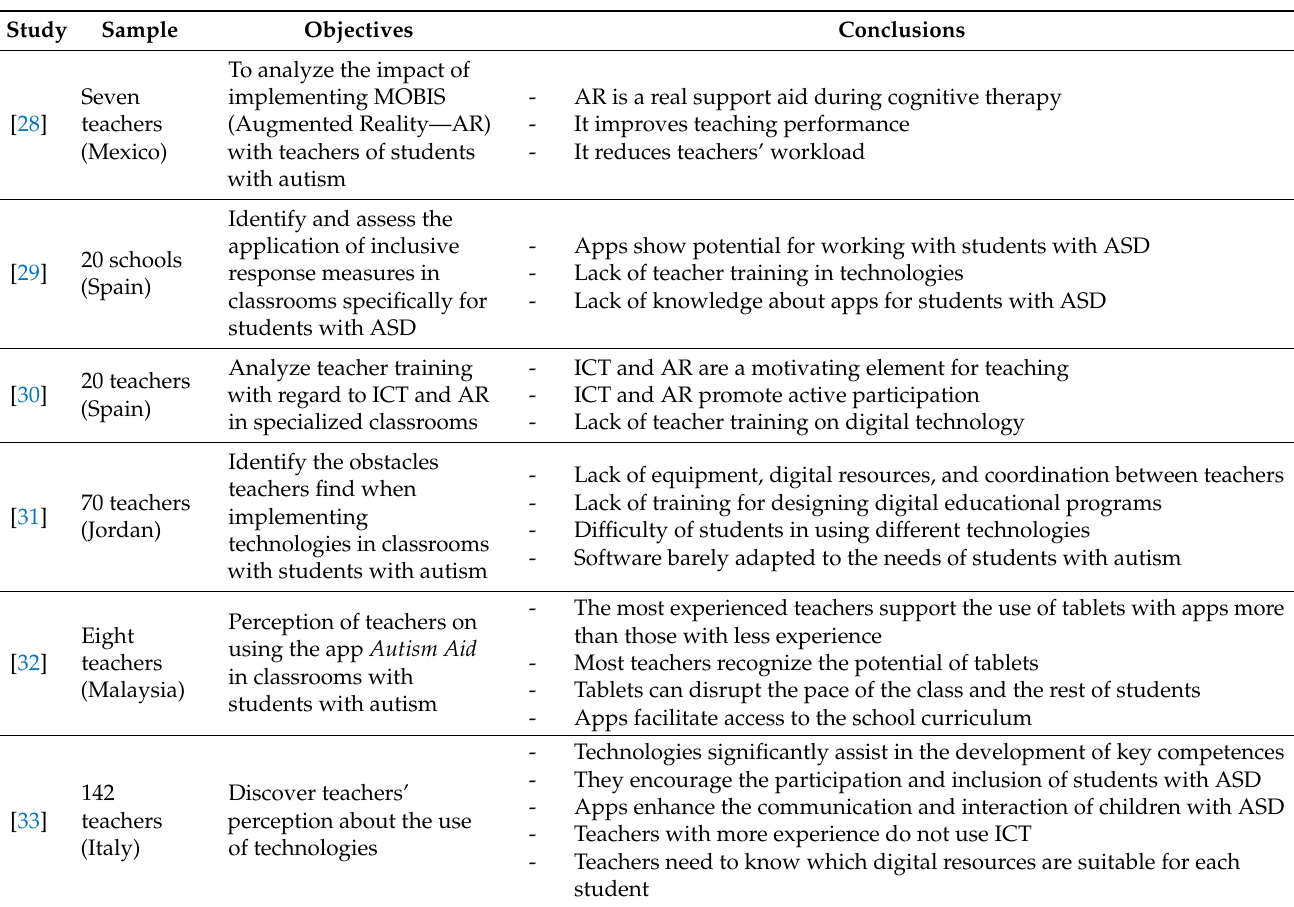
Table 1. Previous studies on the perception of teachers regarding the application of technologies in the classroom with people with